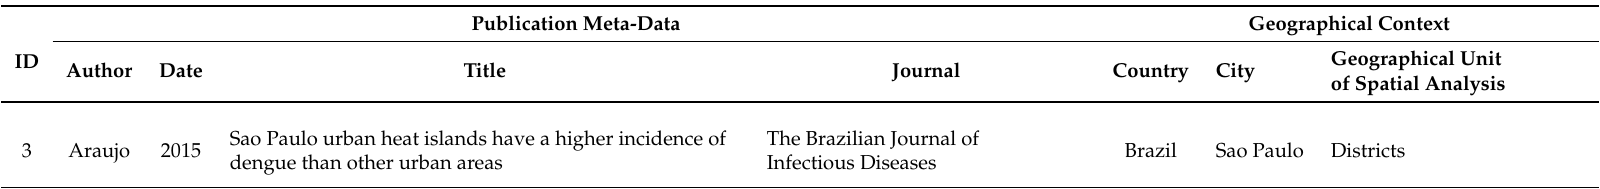
Table 1. Structuring of the data extracted from the articles on the publication meta-data and the geographical context. First line (id: 3) is given as an example. Please refer to the annex-table 1 for the whole dataset ([n = 78] articles).